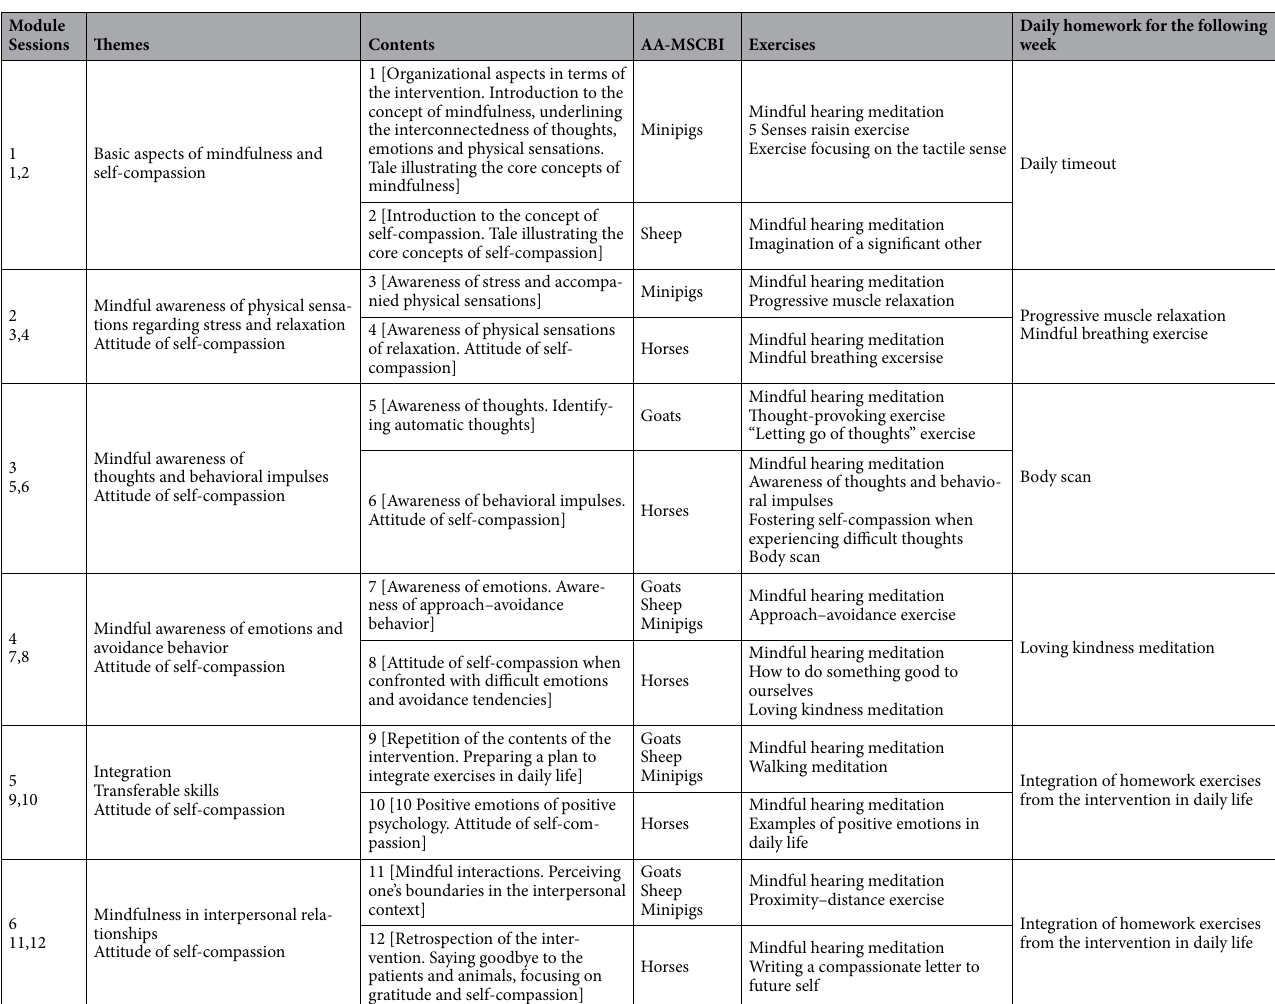
Table 5. Content of the six modules of the mindfulness- and self-compassion-based psychotherapeutic group intervention with (AA-MSCBI) and without (MSCBI) animal-assistance for patients with acquired brain injury. Every module consisted of 2 sessions per week, resulting in 12 sessions in